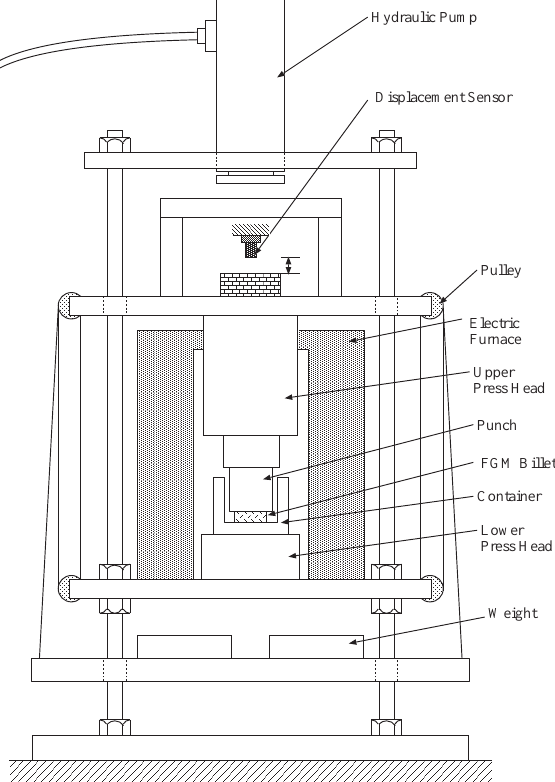
Figure 2. Schematic representation of functionally graded material (FGM) semisolid forming system.